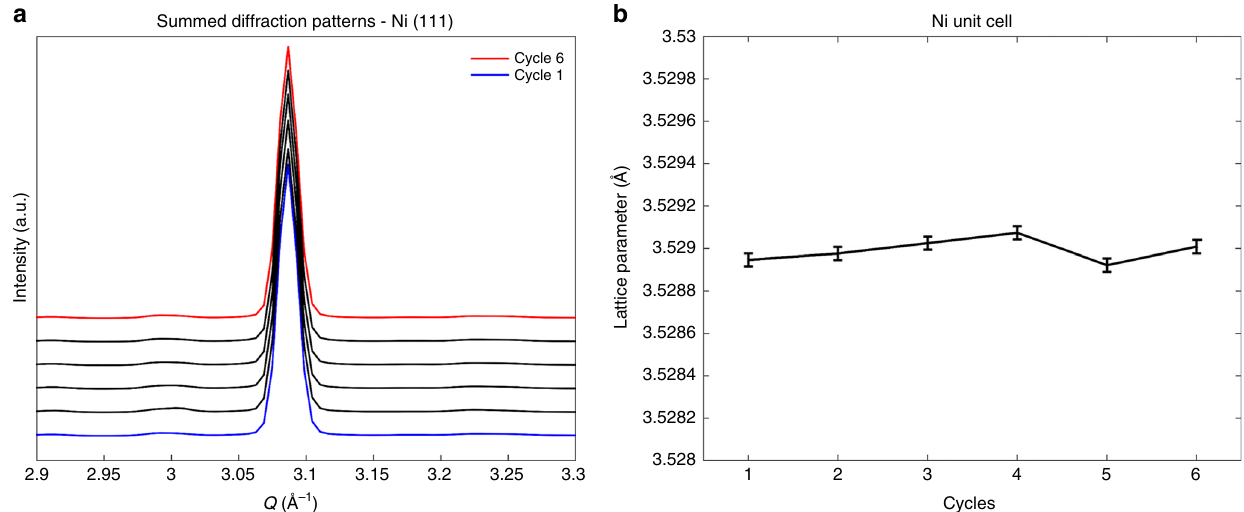
Fig. 4 X-ray results from thermal cycling of the seven-channel solid oxide fuel cell. a The Ni (111) peak (highest intensity peak) with thermal cycling displaying minimal shift, b the Ni unit cell lattice parameter with thermal cycling